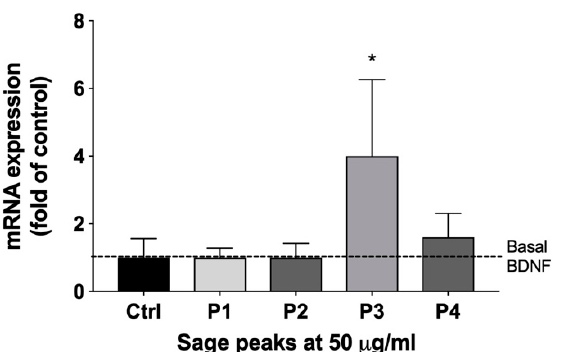
Figure 3. Sage RP-HPLC peak fractions P1 through P4 modulation of BDNF mRNA levels in C6 glioma cells. Samples were screened at an initial concentration of 50 µ g/mL in triplicate. Results were expressed as a fold change of the control. * p < 0.05 versus vehicle control by Tukey's multiple comparison test.